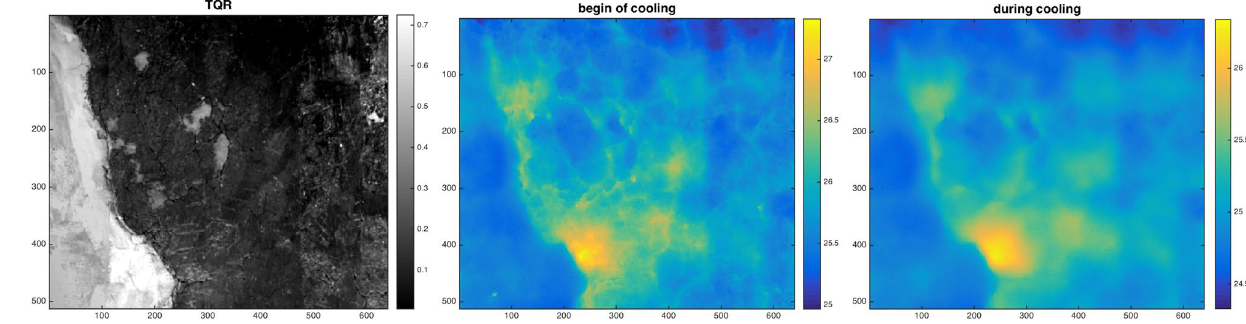
Figure 4. Dual mode MWIR dataset: TQR map and selected thermograms ( ◦ C) from thermal sequence.